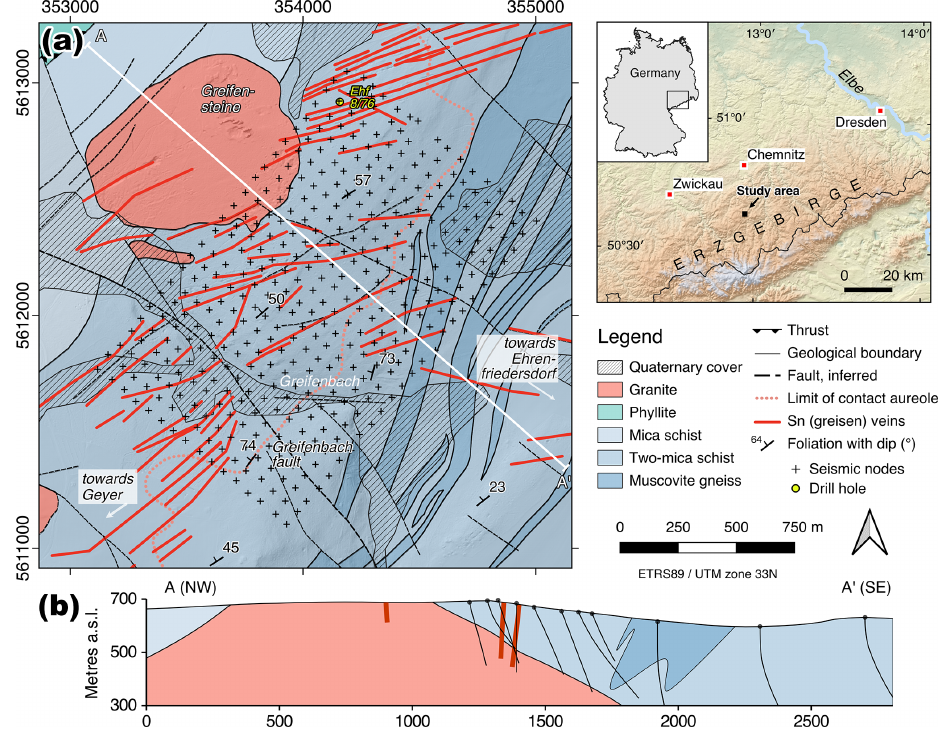
Figure 1. (a) Geologic map and (b) cross-section of the study area. Sources: Sächsisches Landesamt für Umwelt, Landwirtschaft und Geologie (Geological Survey of Saxony); Kirsch and Steffen (2017). Drill holes in the section were projected from a distance of 150m. Crosses in (a) indicate the location of the seismic